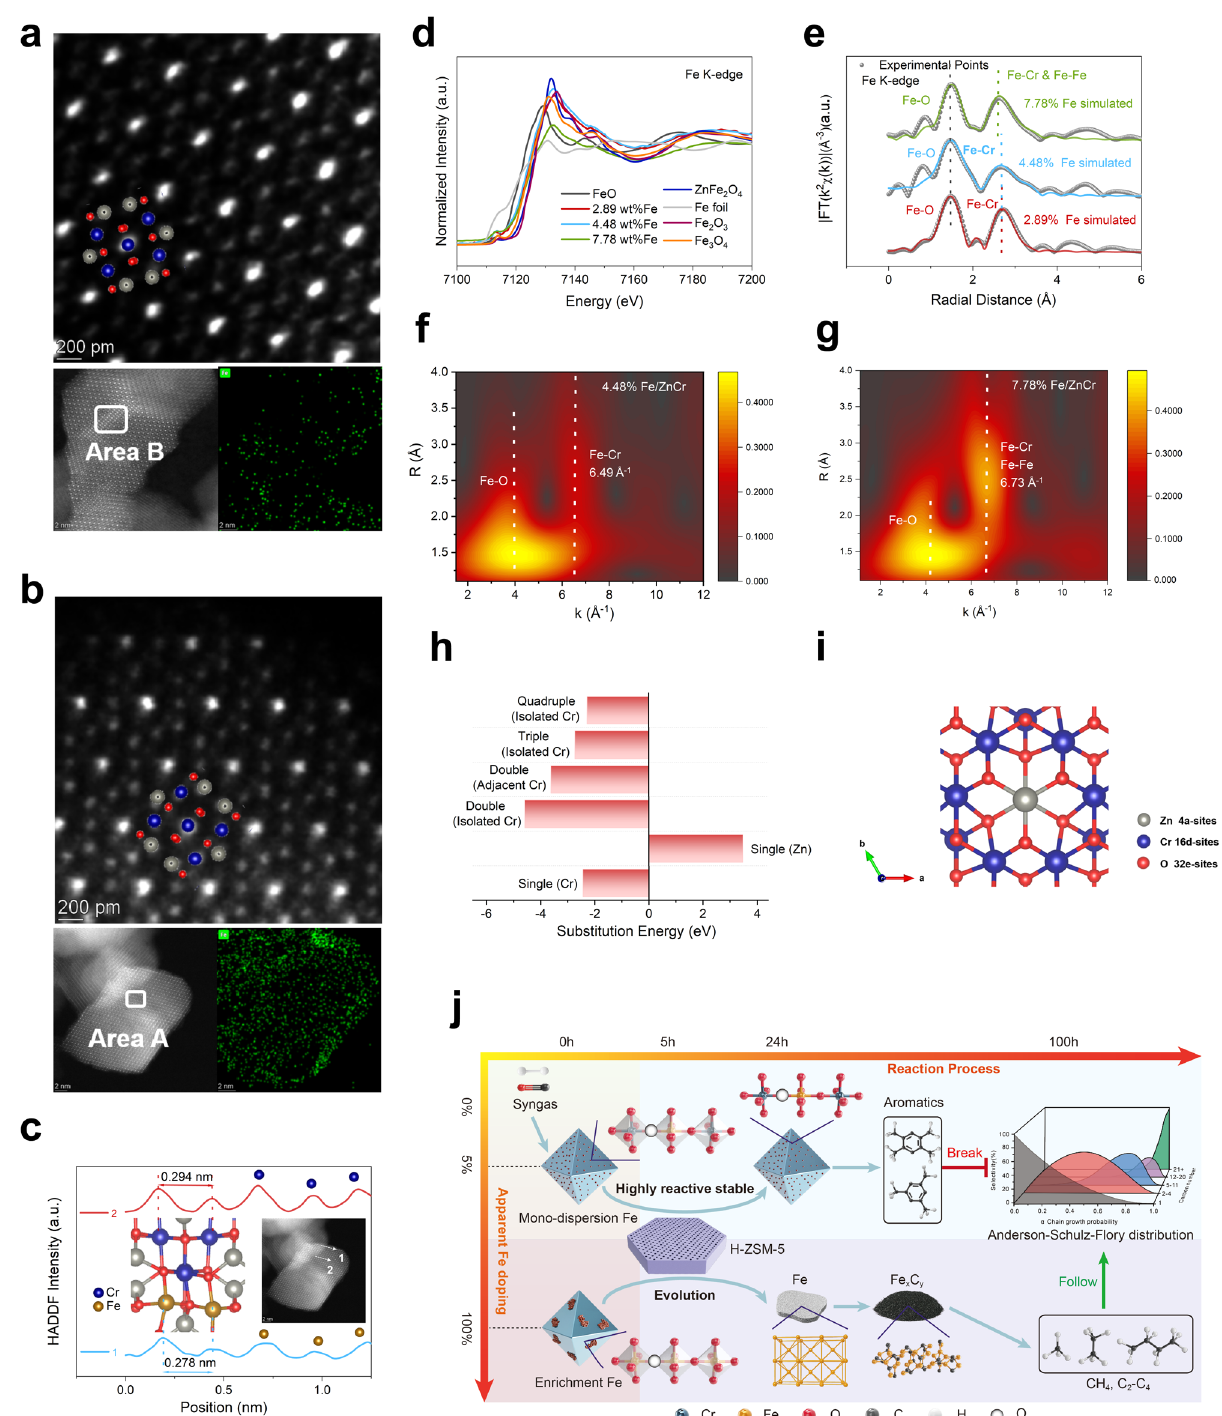
Fig. 1 | Fe monodispersion on ZnCr 2 O 4 spinel. HADDF-STEM images of a 4.48% Fe-Zn/Cr and b 7.78% Fe-Zn/Cr and corresponding EDS mappings of Fe element. c HADDF intensity pro fi le of two lines at the selected regions shown in the inset HADDF-STEMimage.Theatomicstructureof Zn(Cr,Fe) 2 O 4 spinelisalsoshownas an inset to illustrate the distance between two adjacent (16d) sites. d Fe K-edge X- ray absorption near-edge structure (XANES) pro fi les of different Fe-Zn/Cr and somestandardsamples. e The fi rsttwoshells,Fe – OandFe – Cr/Fe – Fe fi ttings,ofthe Fe K-edge Fourier transform-extended X-ray absorption fi ne structure (FT-EXAFS)